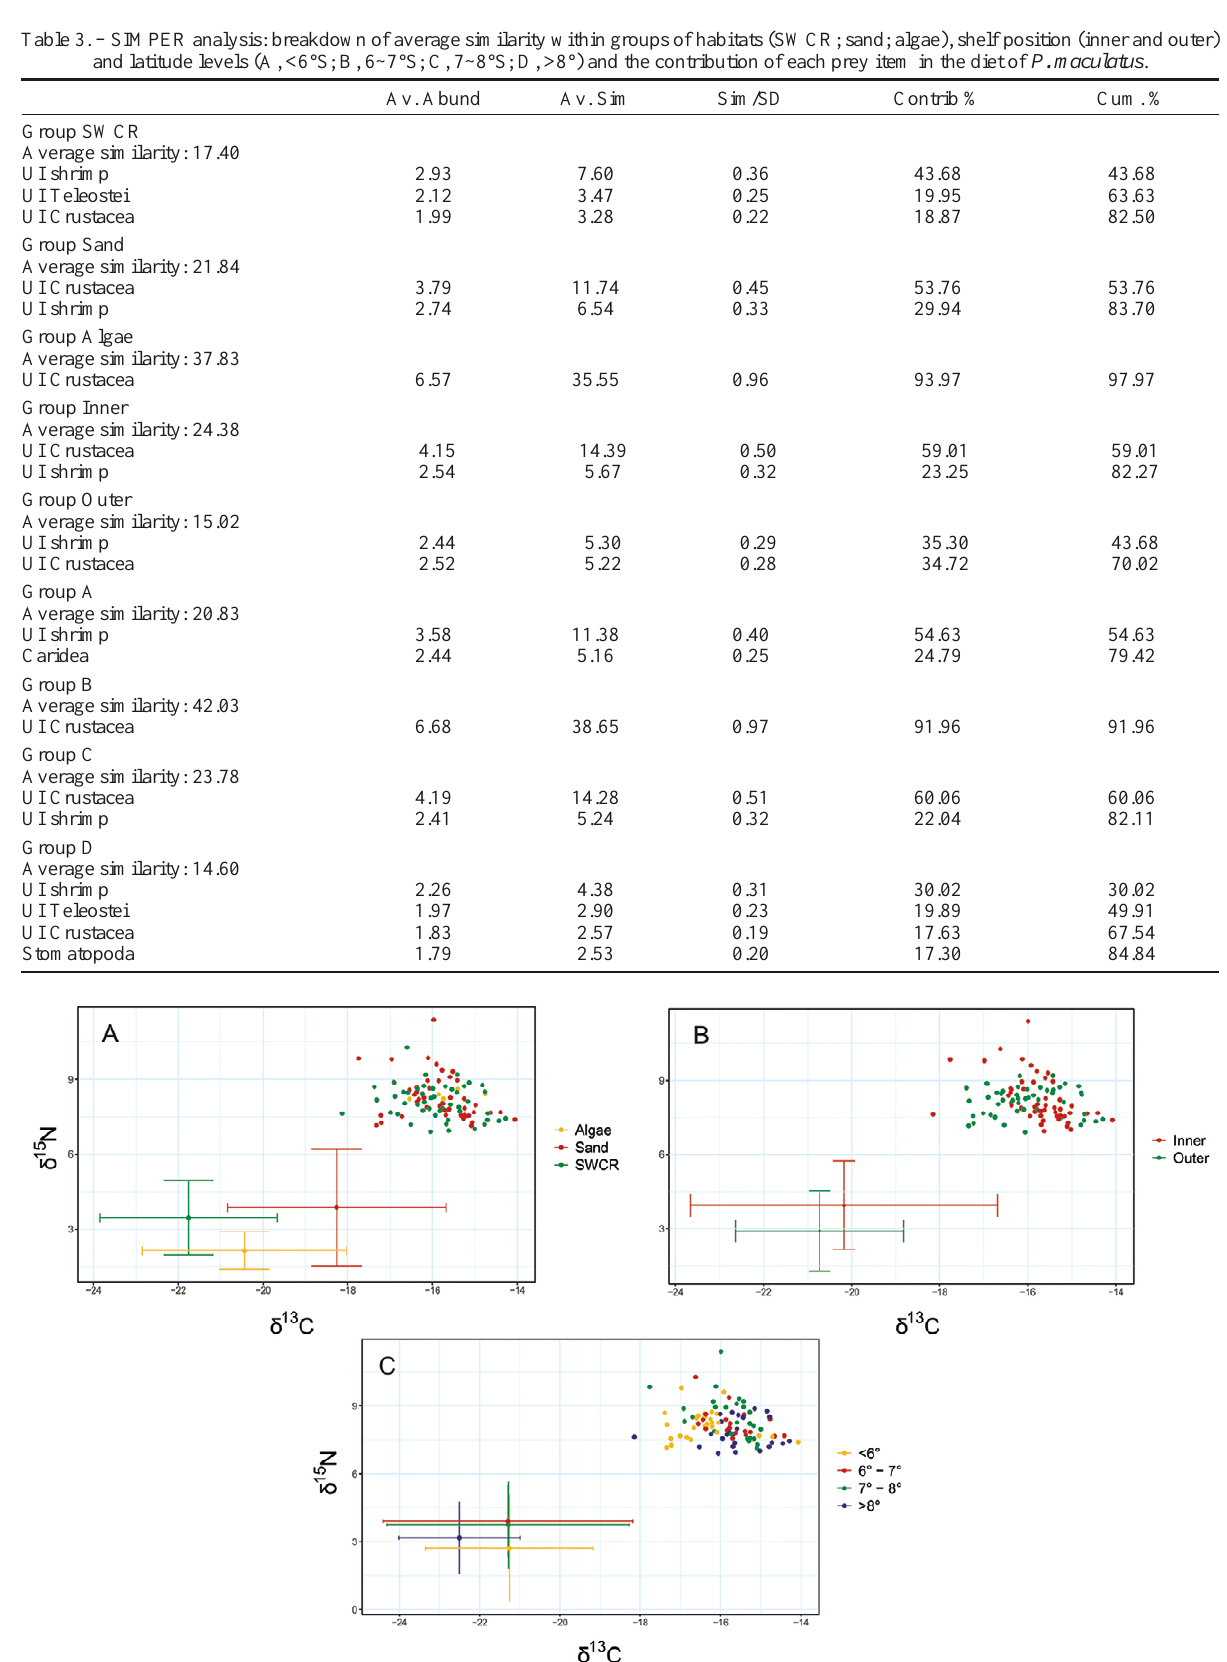
Fig. 8. – δ 13 C and δ 15 N values of P. maculatus . Colours represent different levels of habitat (A), shelf position (B) and latitude gradient (C). δ 13 C and δ 15 N signatures of zooplankton are also shown